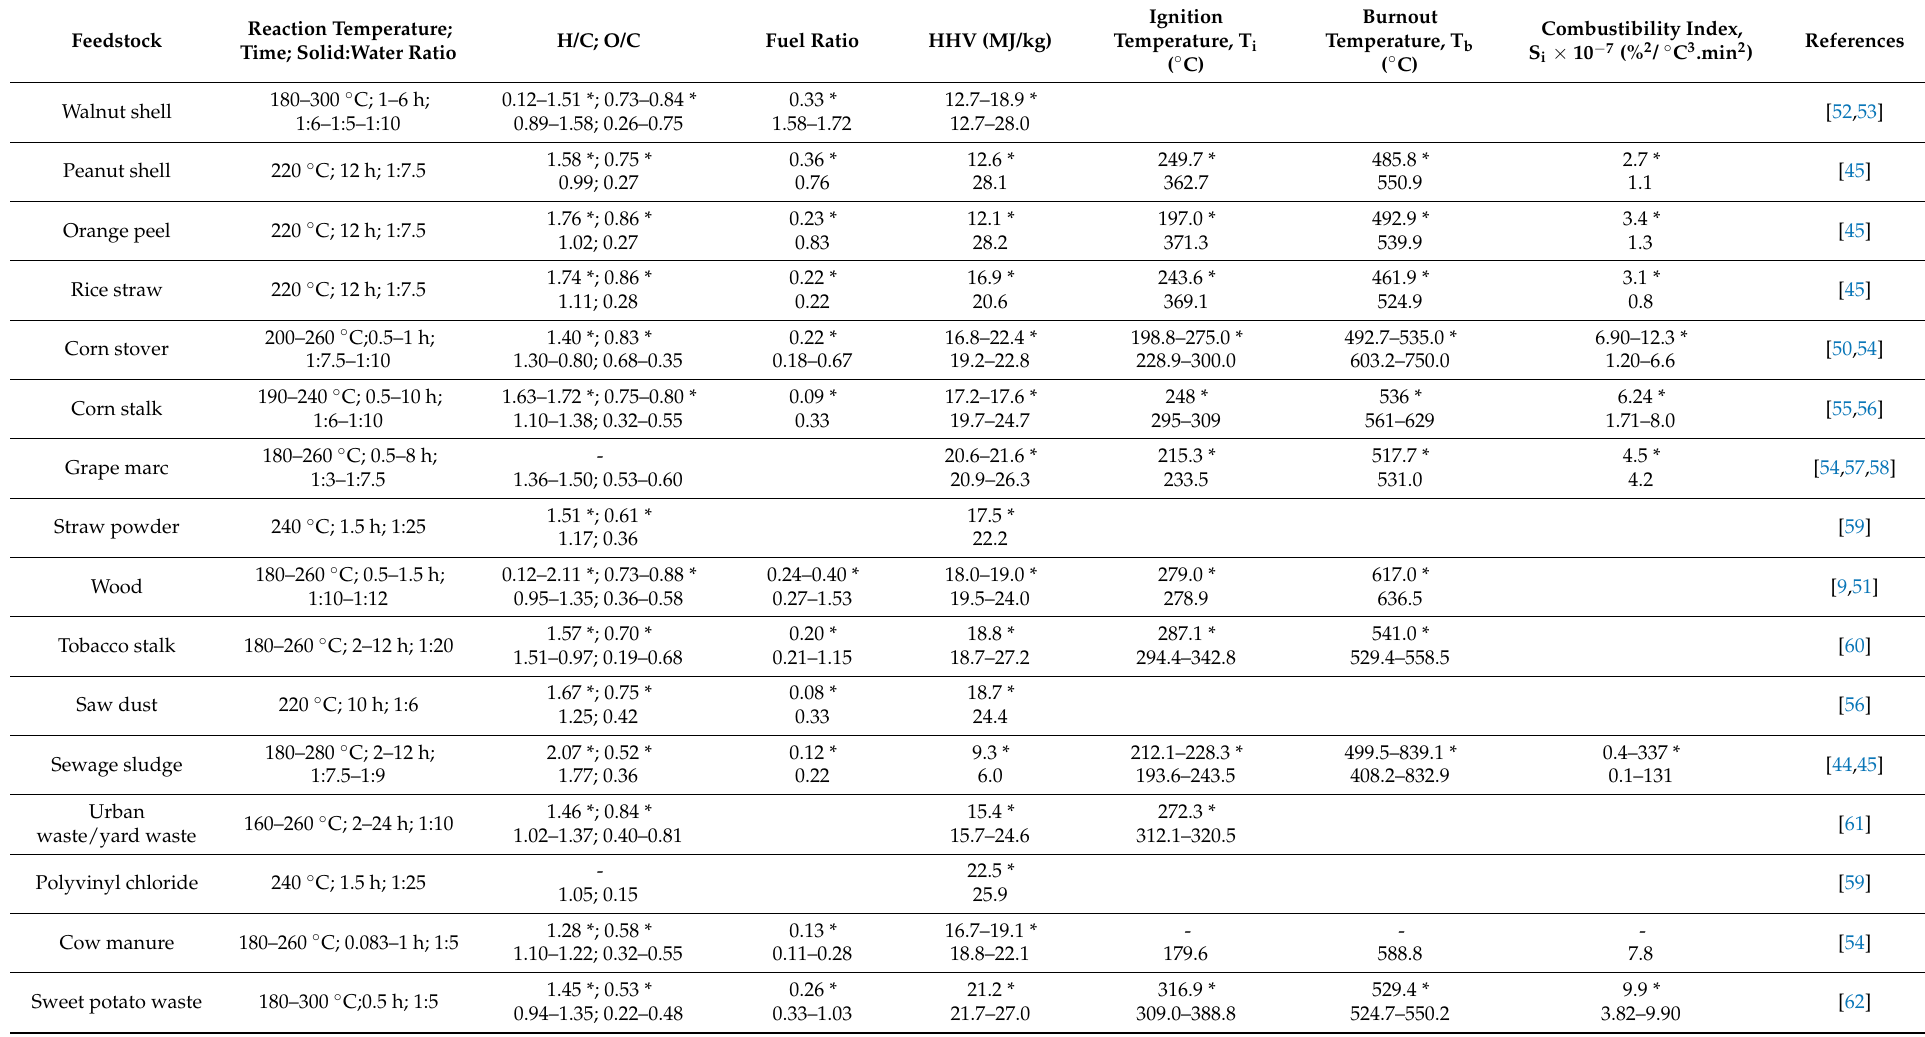
Table 1. Fuel and combustion properties of